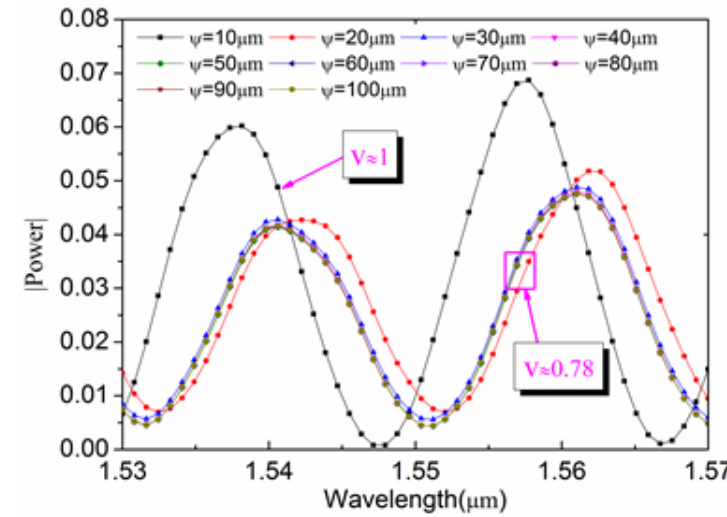
Figure 5. The microcavity interference spectra of different cavity diameters (wavelength range is 1520~1570 nm; the model parameters are: cavity length L of 60 µ m, curvature radius of reflector II φ 2 = ∝ , and cavity diameter ψ 10~100 µ m.)